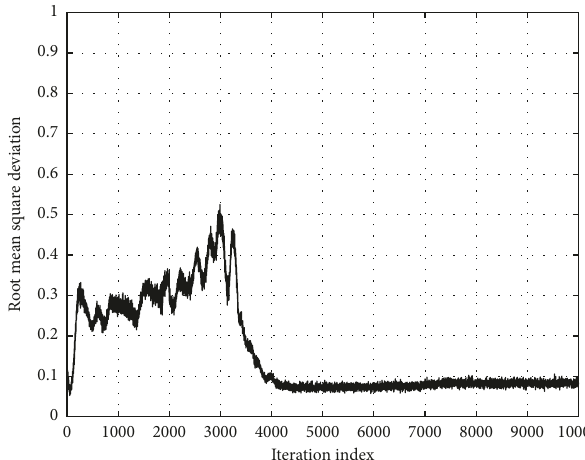
Figure 5: Emulation error vs. iteration